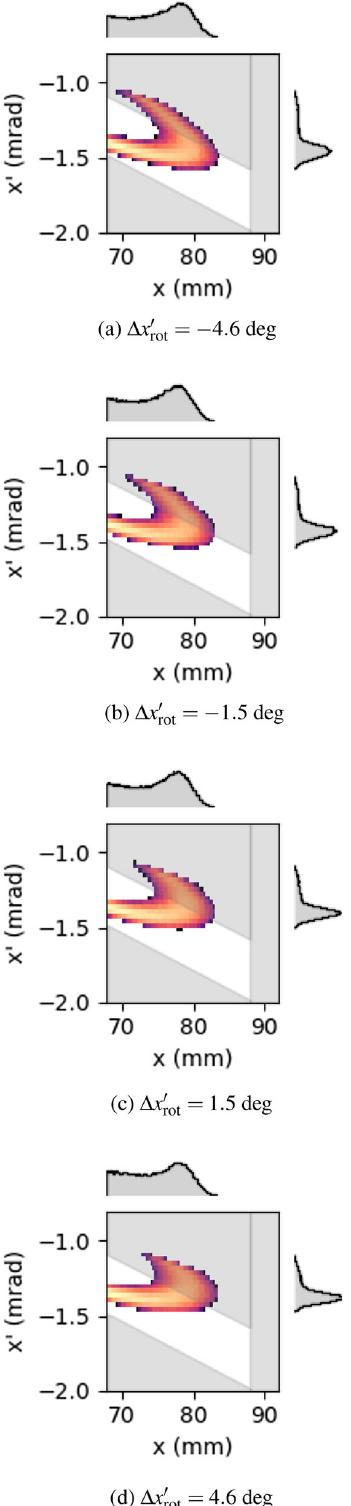
FIG. 12. Extracted beam in phase space on the high-field side up- stream of the ZS simulated as a function of resonance driving term rotation knob ( Δ x 0 ) with 2.1 times the nominal LSE strength, i.e., rot